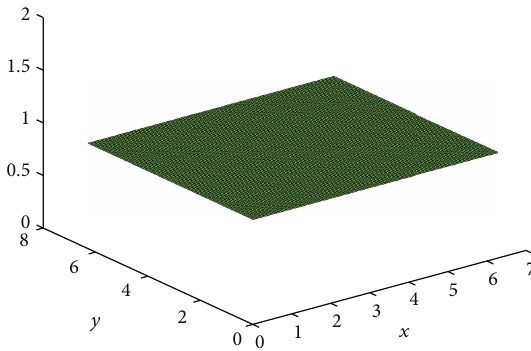
Figure 9: Interaction of two solitons |𝜓| 2 and |𝜙| 2 at 𝑡 = 1.5 .